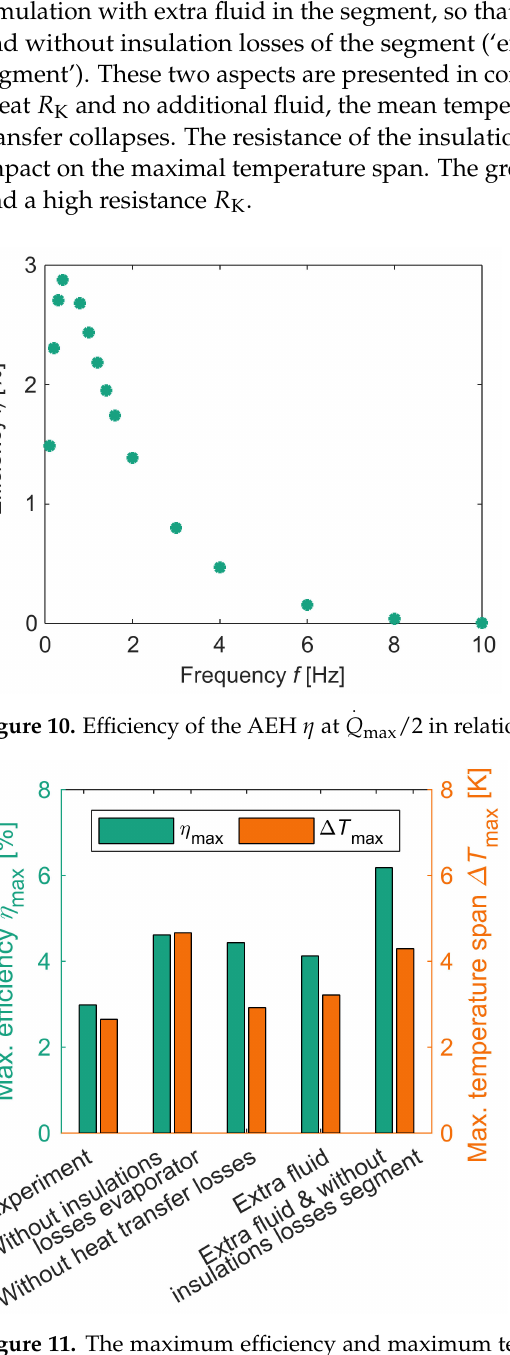
Figure 11. The maximum efficiency and maximum temperature span for different scenarios. The simulation of the experiment on the left is given as a reference. In the scenario ’without insulations losses evaporator’, no insolation losses in the evaporator are assumed. ‘Without heat transfer losses’ represents a scenario where there is no resistance between the ECM and the fluid. In the scenario ‘extra fluid’, additional fluid is assumed to be on the surface of the ECM. The last column shows a scenario with ‘extra fluid and without insulations losses segment’ and no insulation losses in the